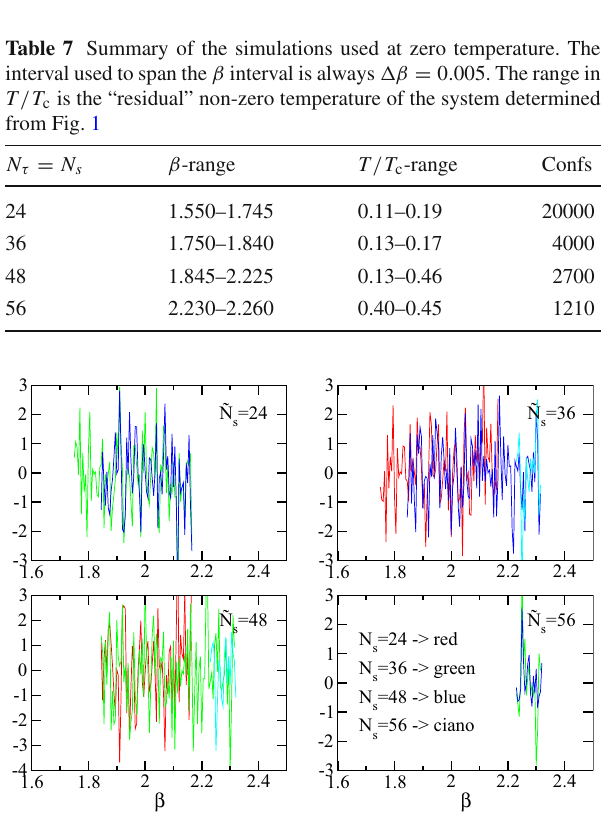
Fig. 9 In this plot we show the finite volume effects of our simulations at zero temperature. We plot the quantity [ P ( N s ) − P ( ˜ N s ) ] /(cid:13) P ( ˜ N s ) , where P ( N s ) is the value of the spatial plaquette measured at the spatial volume N 4 s and (cid:13) P is its error. Comparing the results from different volumes, in the same range of β , we can see that the difference is always smaller than three standard deviations